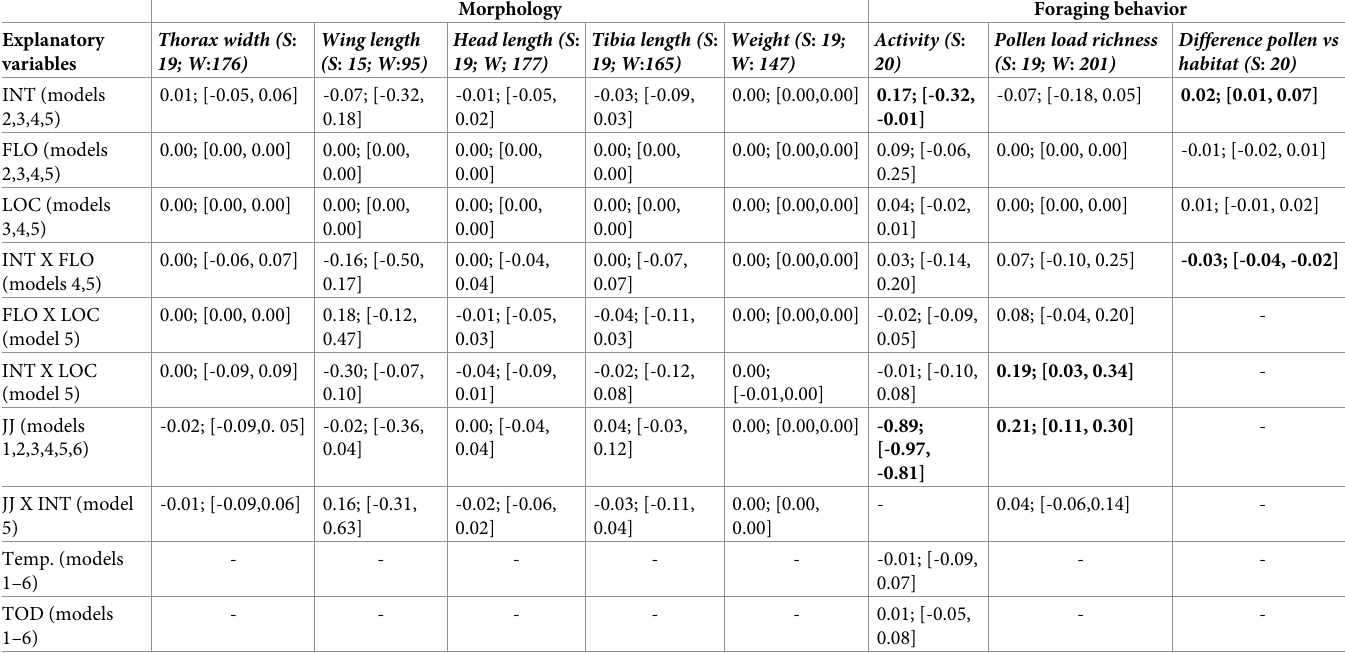
Table 2. Model-averaged coefficients and their unconditional 95% confidence intervals. Model-averaged coefficients were estimated by multimodel inference follow- ing model selection (see Table 1) and computed with standardized explanatory variables (zero mean and unit variance). Parameters for which their confidence interval does not overlap zero are shown in bold text. The number of sites (S) and of workers (W) used in analyses are shown where applicable.